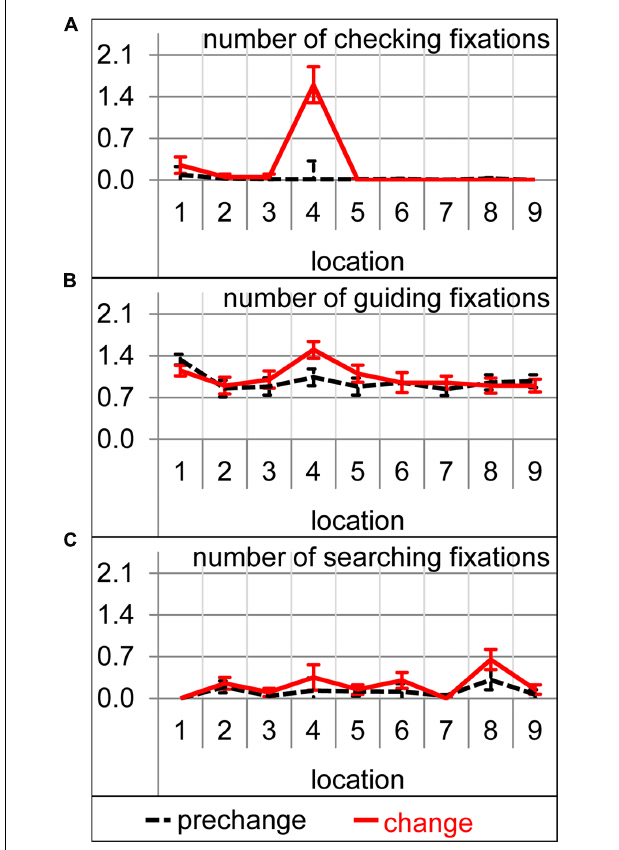
FIGURE 4 | Number of the checking (A), guiding (B) , and searching (C) fixation per trial on each of the nine target locations during prechange baseline (broken black lines) and the first change trial (solid red lines). Error bars represent standard errors of the paired difference between prechange and change for each